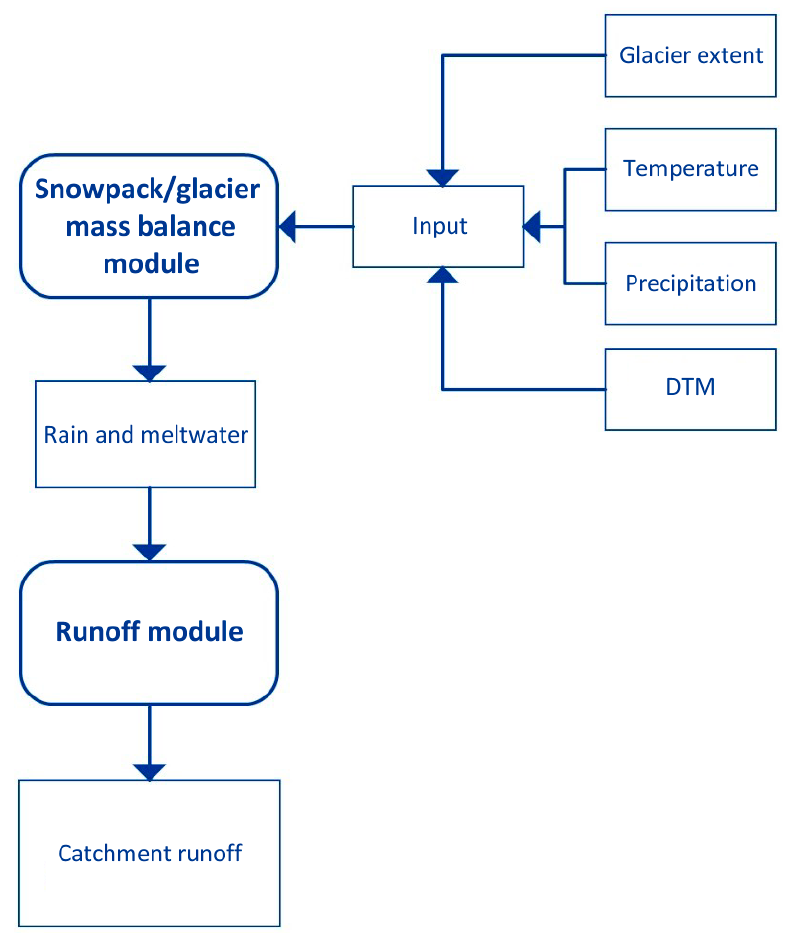
Figure 3. Simplified scheme of the EISModel 4.0 structure.